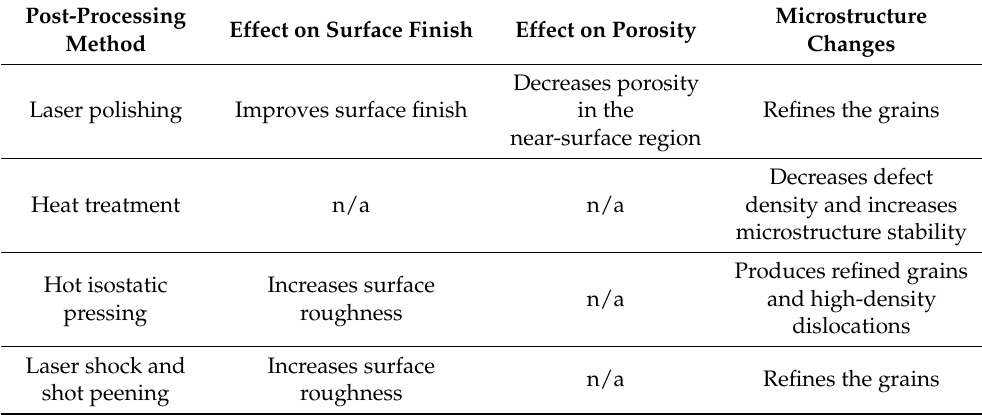
Table 2. Summary of effects of post-processing effects on AM metals